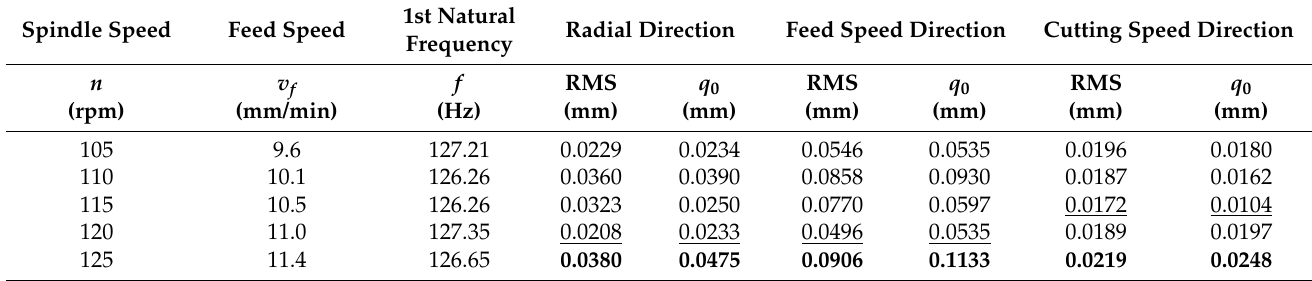
Table 2. Simulated vibrations displacements of the edge tip. The RMS values and dominant peaks of amplitudes in spectra. Underlined value—the best configuration, bold value—adverse configuration.